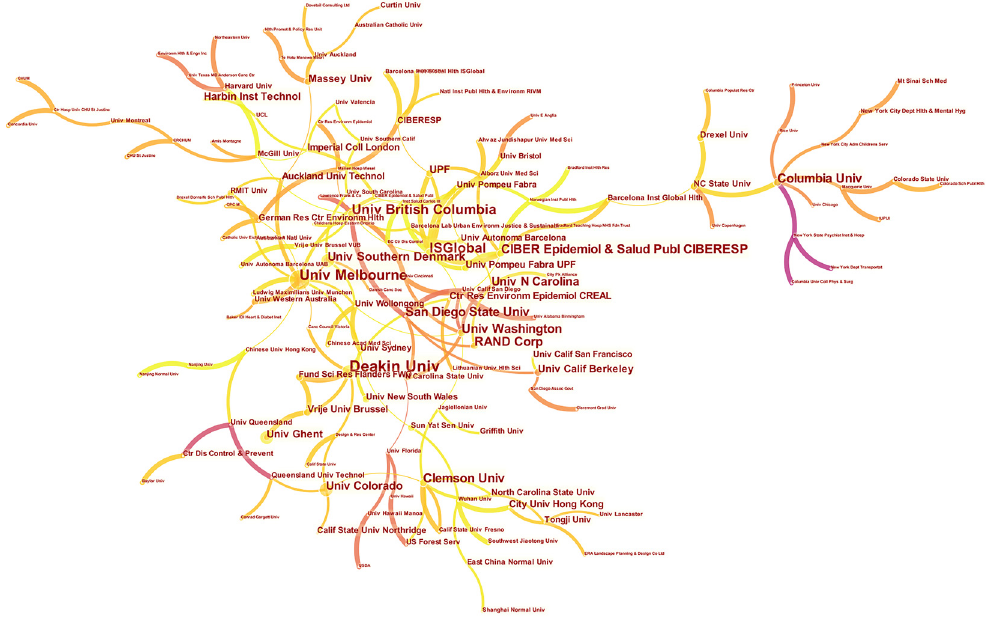
Figure 5. Collaboration network of institutions.